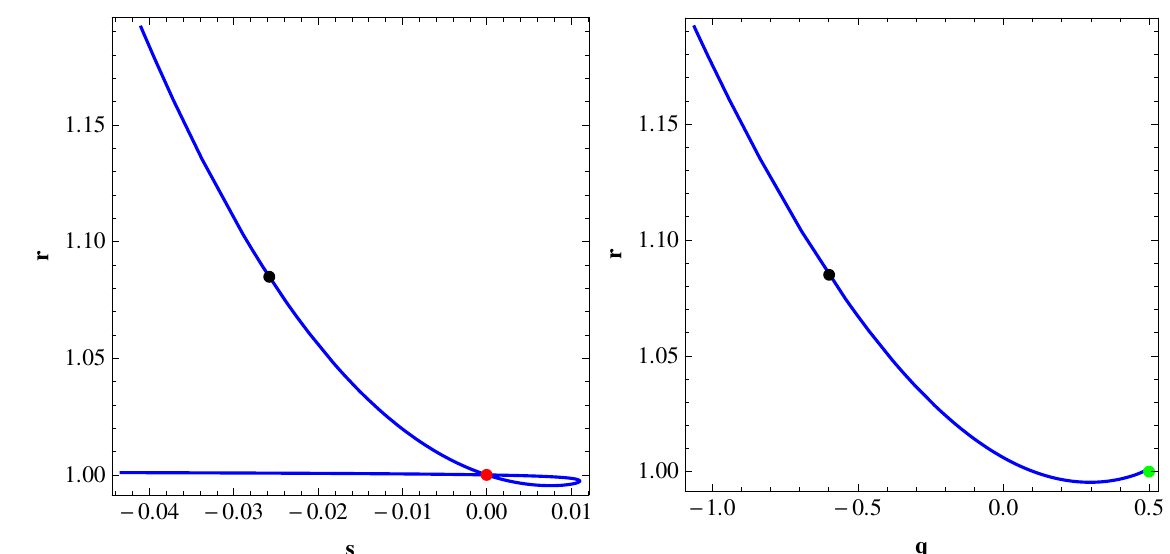
Figure 4. The time evolutions of the statefinder pair ( s , r ) ( left panel) and the pair ( q , r ) ( right panel) for this model are shown using the H ( z ) + BAO + CMB + BBN + SNIa (Pantheon) dataset, as indicated in each panel. The red point ( s = 0, r = 1 ) in the left panel corresponds to the Λ CDM model, while, in the right panel, the green point ( q = 0.5, r = 1 ) represents the matter dominated Universe (SCDM). In addition, the black dots on the curves show present values ( s 0 , r 0 ) ( left panel) and ( q 0 , r 0 ) ( right panel) for the NGCG model.